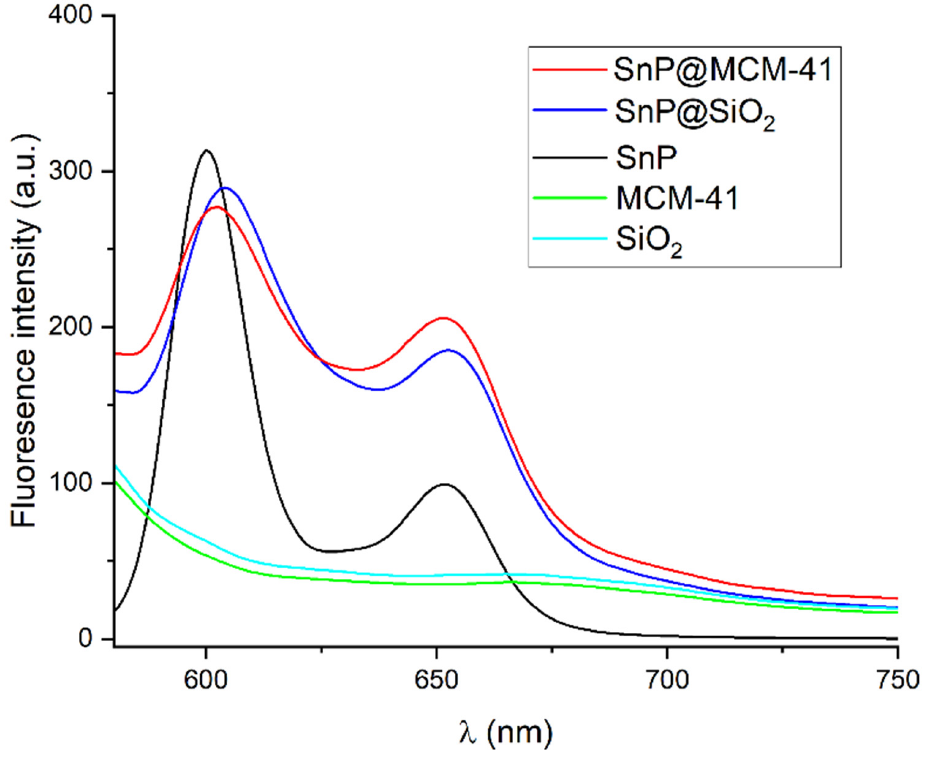
Figure 3. Fluorescence spectra of SnP , SiO 2 , MCM − 41, SnP@MCM − 41 , and SnP@SiO 2 in a Nujol paste ( λ ex = 560 nm).